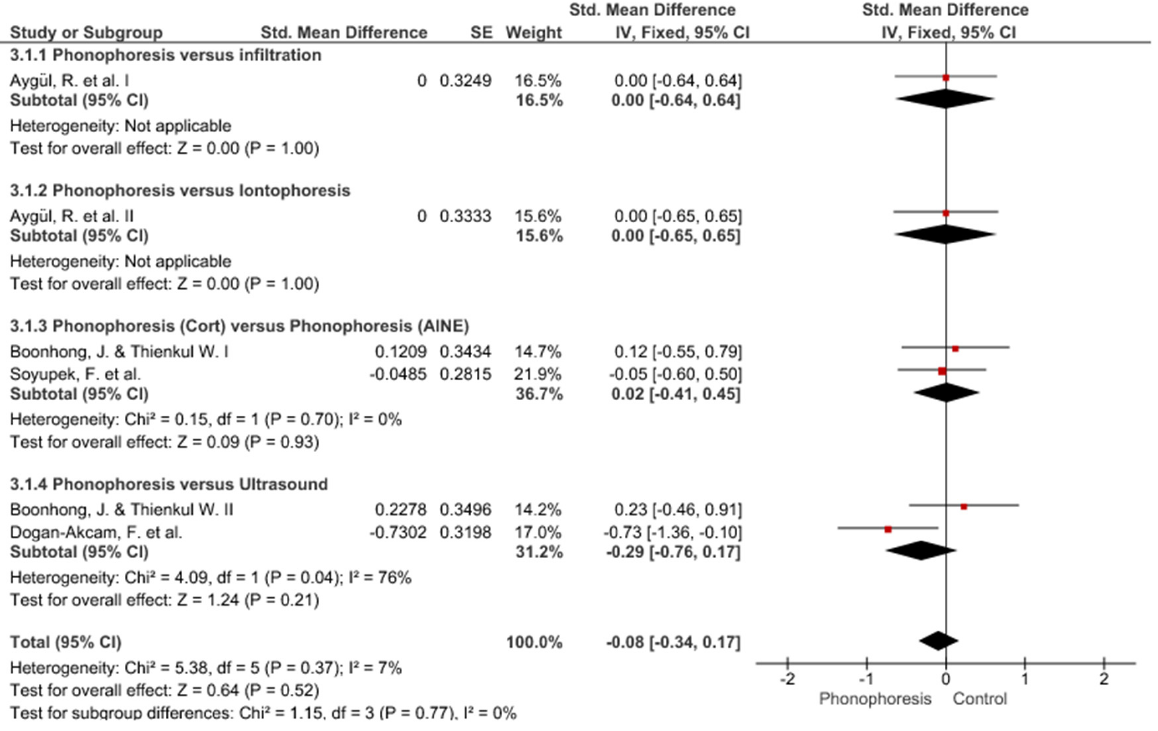
Figure 4. Phonophoresis for BCTQ Function.